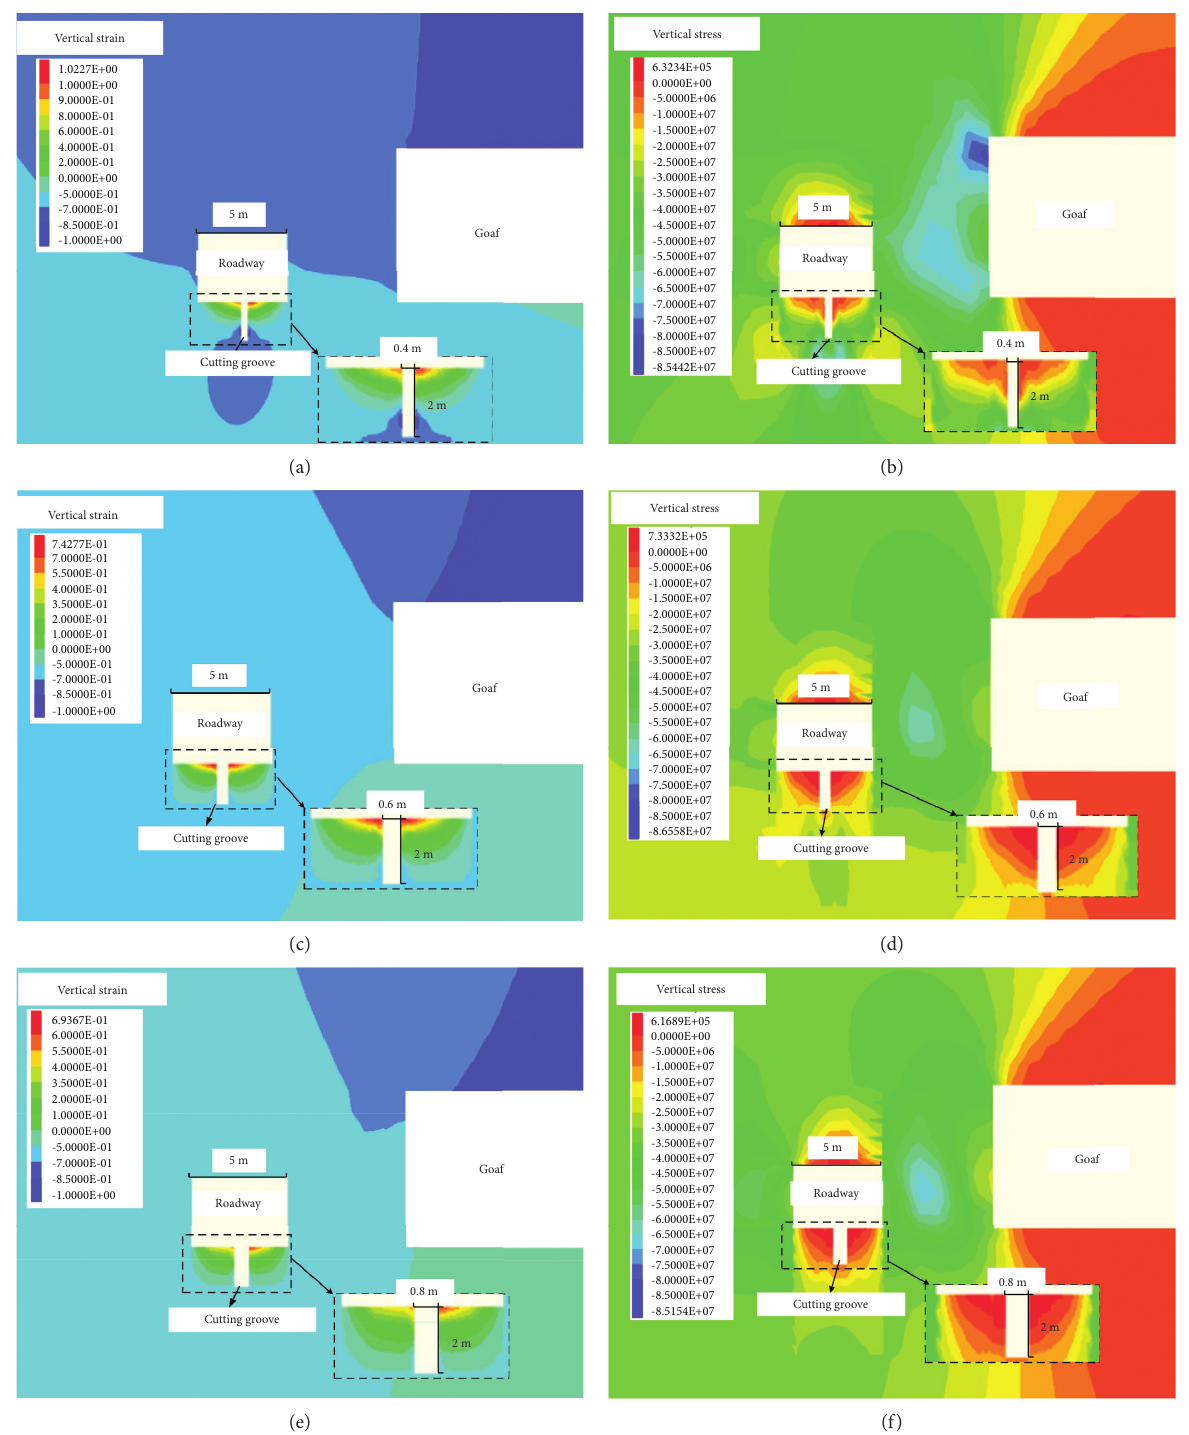
Figure 7: Deformation and stress distribution of roadway surrounding rock with different floor cutting groove width. (a) Vertical strain of 0.4m; (b) vertical stress of 0.4 m; (c) vertical strain of 0.6 m; (d) vertical stress of 0.6m; (e) vertical strain of 0.8m; (f) vertical strain of